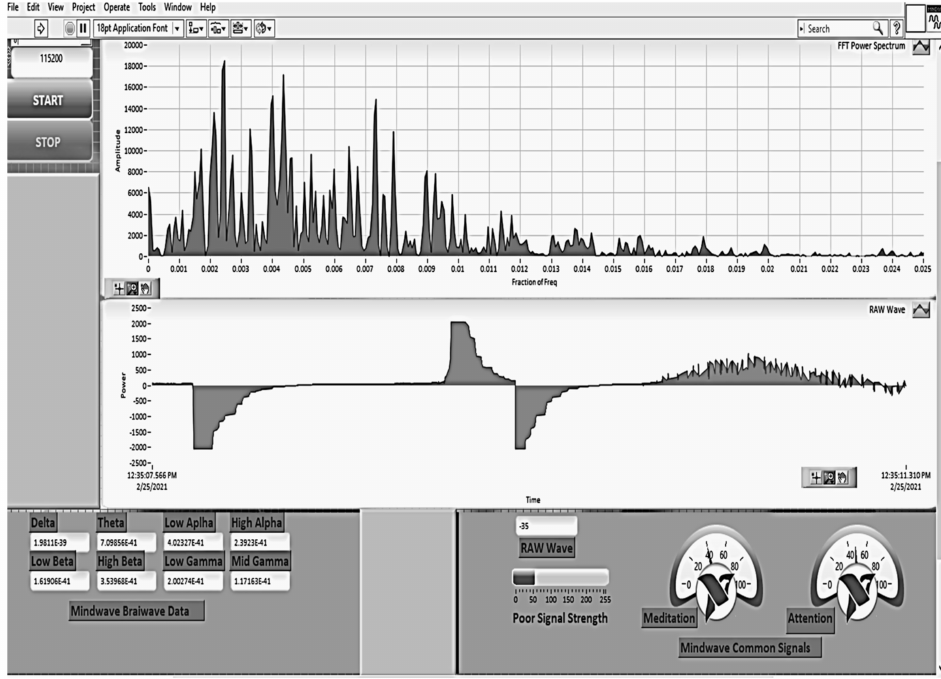
Figure 18. Simultaneous detection of cognitive states of meditation and attention using the modified RBF neural